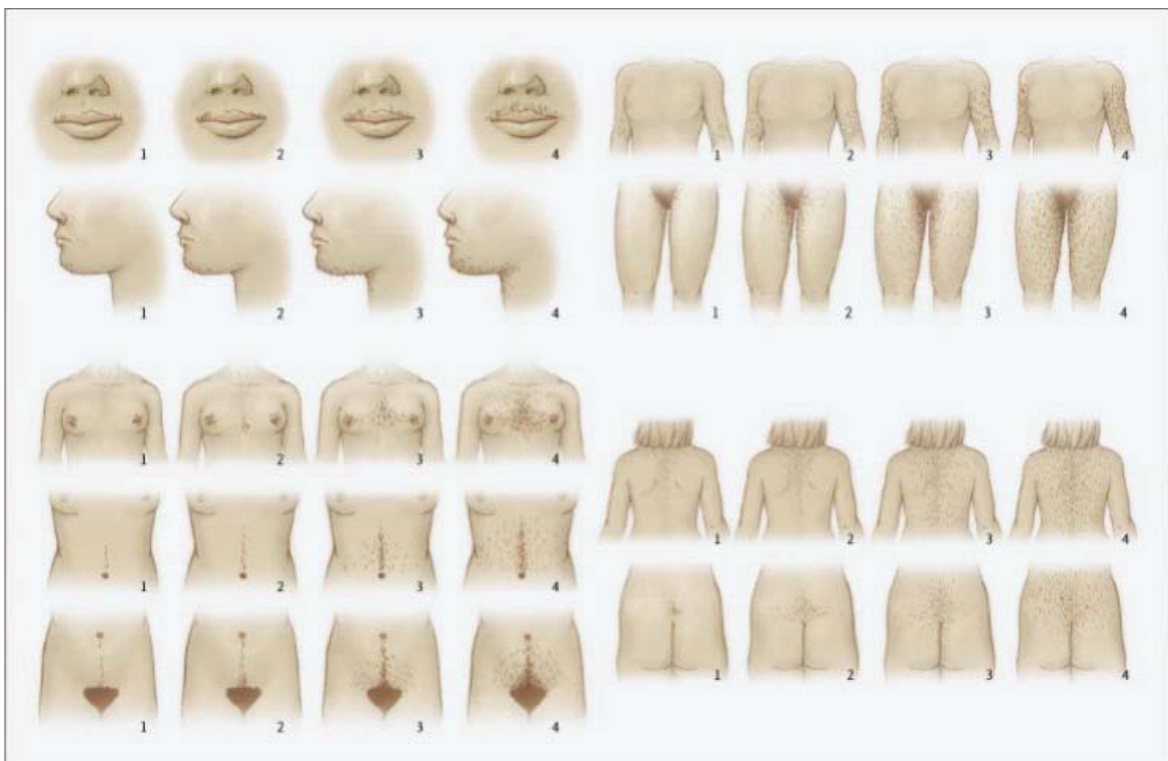
Figure 1. The Ferriman-Gallwey scoring system for hirsutism 2 (Nine body areas which are most sensitive to androgen is assigned a score, from 0 (no hair) to 4 (frankly virilized), and summed to provide the clinical hirsutism